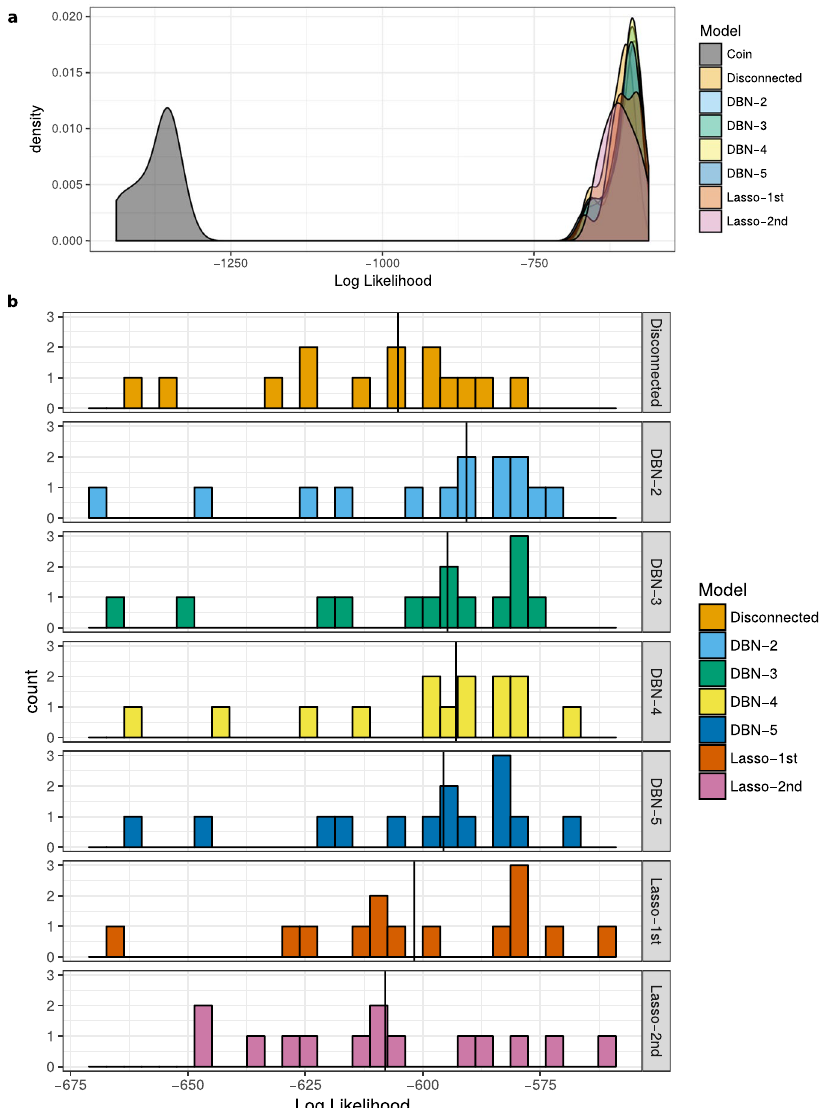
Figure 3. Log likelihood distributions for Tatoosh data subsamples, ( a ) including the weighted coin flip null model, and ( b ) excluding the weighted coin flip, and zooming in on the remaining models. Each observation represents the log likelihood of correctly predicting out-of-sample test data, given the model fit on one subsampled dataset. Black vertical lines in ( b ) represent the median log likelihoods for each